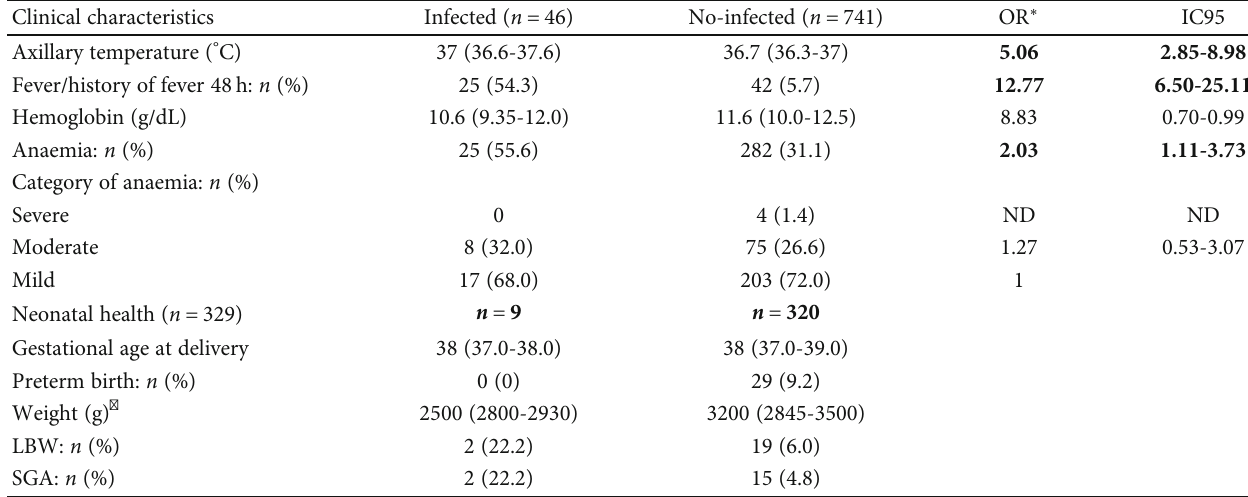
Table 4: Clinical characteristics of infected pregnant women and birth outcomes. Clinical